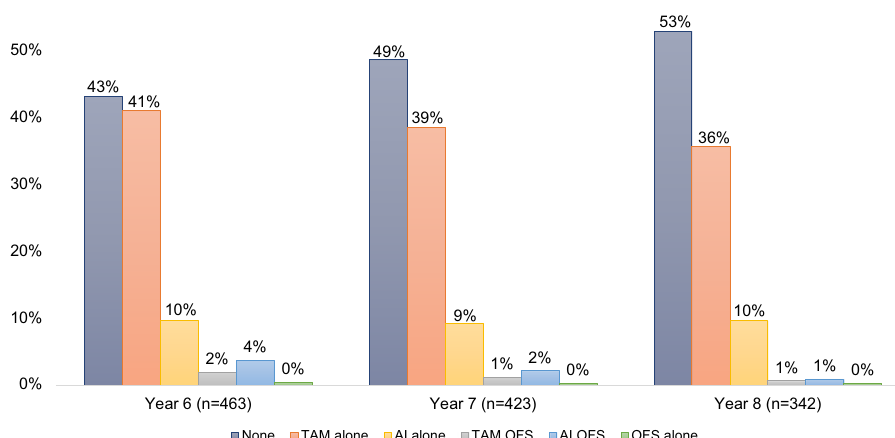
Fig. 2 Extended endocrine therapy use and type at years 6, 7, and 8 post-diagnosis. Purple: no endocrine therapy, orange: tamoxifen, yellow: AI alone, gray: tamoxifen with OFS, blue: AI with OFS, green: OFS alone. TAM, tamoxifen; AI, aromatase inhibitor; OFS, ovarian function suppression. At the 7-year timepoint, 1